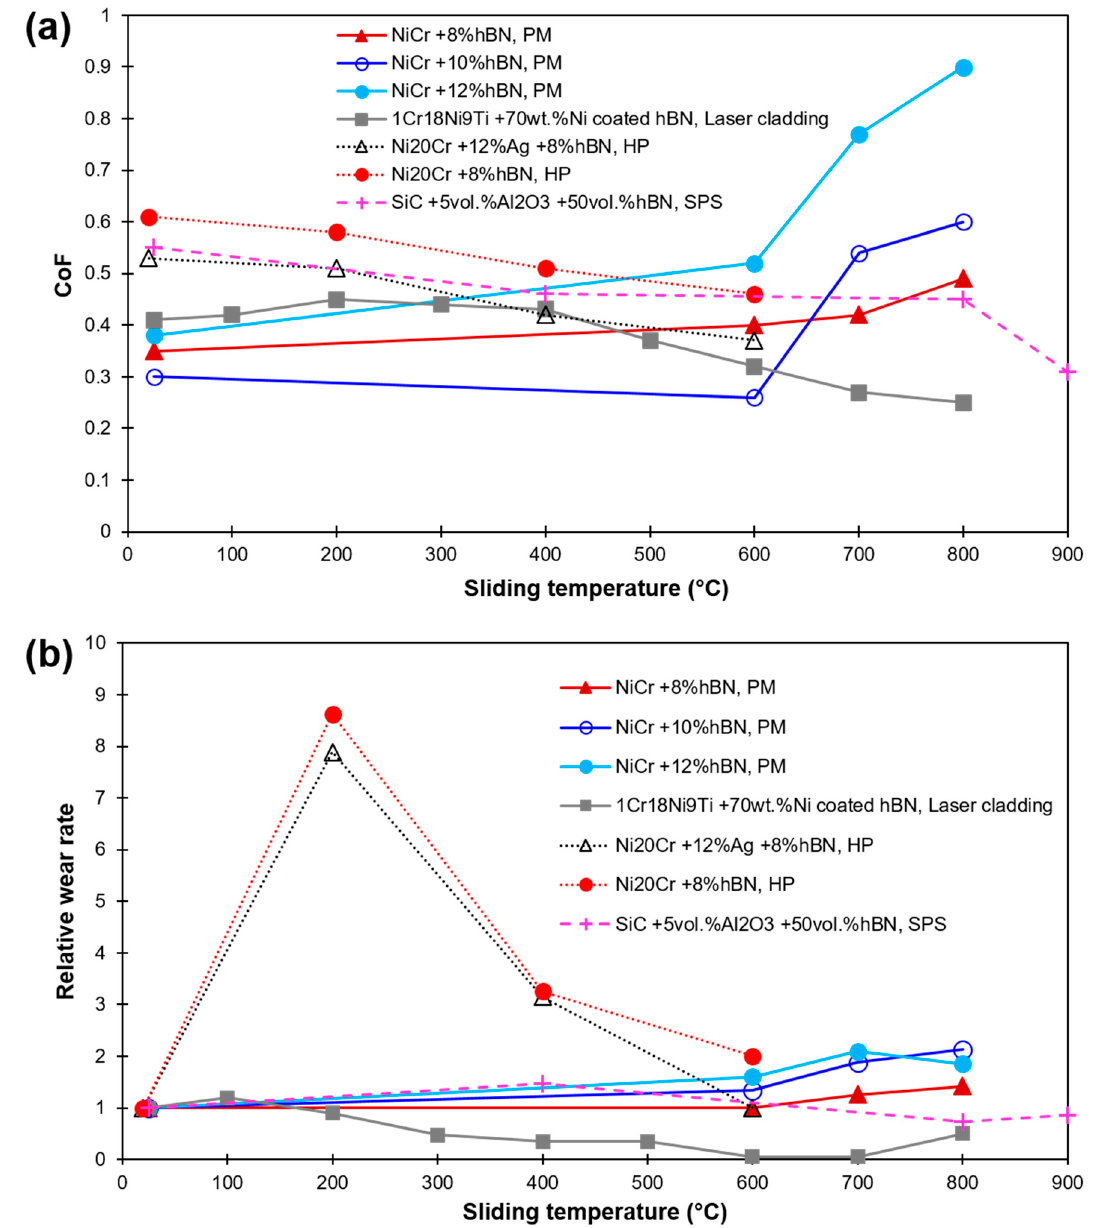
Figure 7. HT sliding results of hBN ‐ based composites and coatings as found in recent literature ( a ) CoF; ( b ) Relative wear rate (in relation to their corresponding RT wear). Values are labeled as per hBN concentration, matrix material, and fabrication method [80–86].